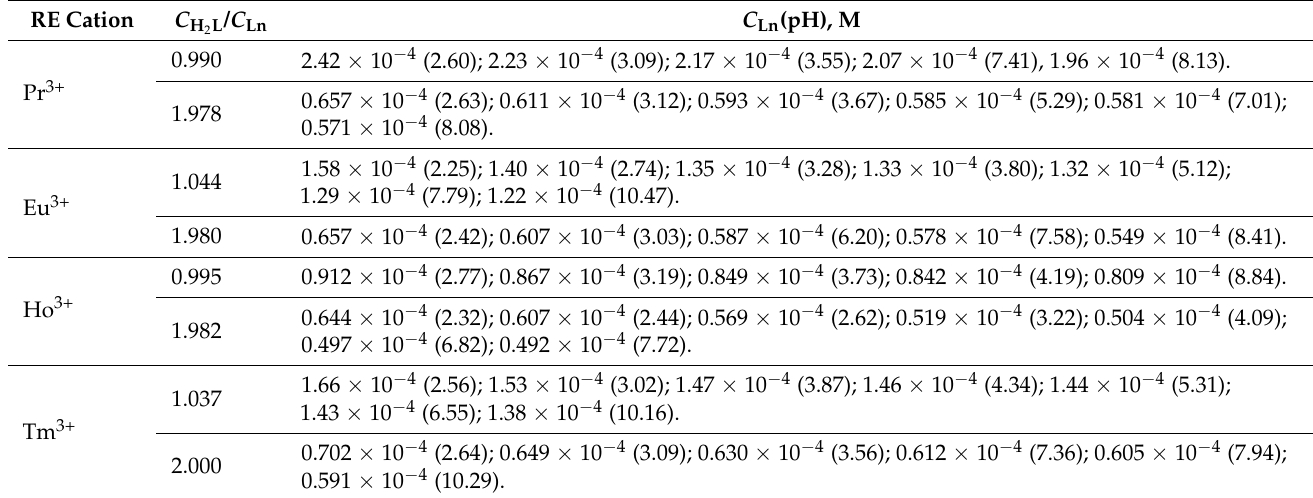
Table 2. Summary of analytical composition and pH of solutions of harzianic acid and, respectively, of Pr 3+ , Eu 3+ , Ho 3+ , and Tm 3+ in the 0.1 M NaClO 4 /(CH 3 OH + H 2 O 50/50 w / w ) solvent employed to collect CD and UV-Vis spectrophotometric data. C H = analytical molar concentration of harzianic 2 L acid; C Ln = analytical molar concentration of rare-earth cation; C H / C Ln = analytical ligand to 2 L rare-earth cation ratio; pH = − log[H + ]. All CD and UV-Vis spectra were acquired by employing 0.2 cm optical path quartz cuvettes. C Ln (pH),